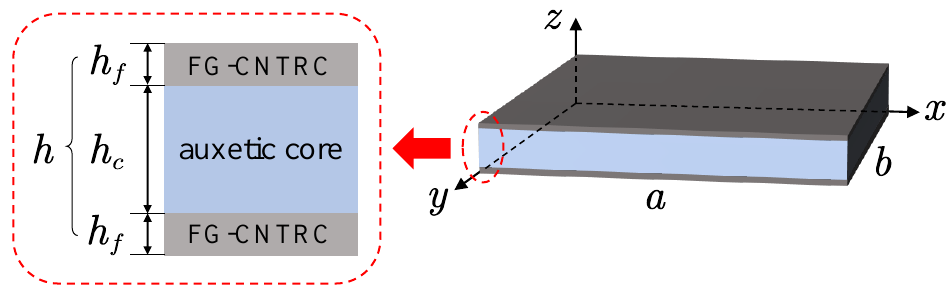
Figure 1. The sandwich plates with FG-CNTRC face sheets and auxetic honeycomb core.